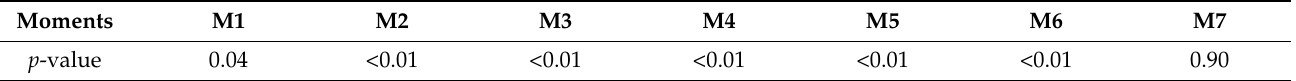
Table 1. Results for t -test ( p <